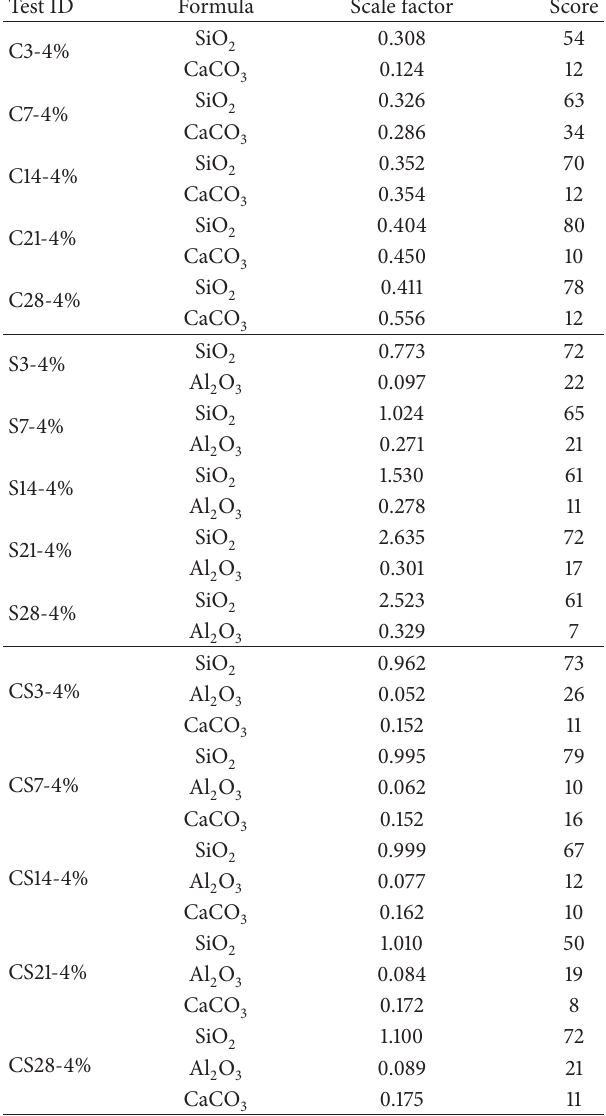
Table 6: Specimen curing period in accordance with the results of XRD